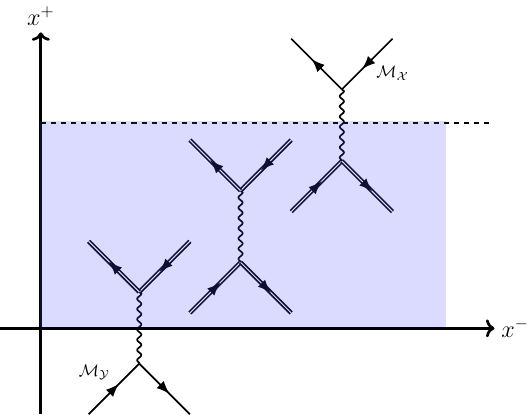
Figure 2. Illustration of some terms in the decomposition (2.23). The shaded region indicates the sandwich plane wave (cid:12)eld. One vertex in the terms M X and M Y e(cid:11)ectively lies outside the (cid:12)eld, and so is represented by background-free vertices (single lines). The terms M on , M " and M # , are dressed (double lines) at each vertex, however the way in which each vertex interacts with the background is distinct (see the